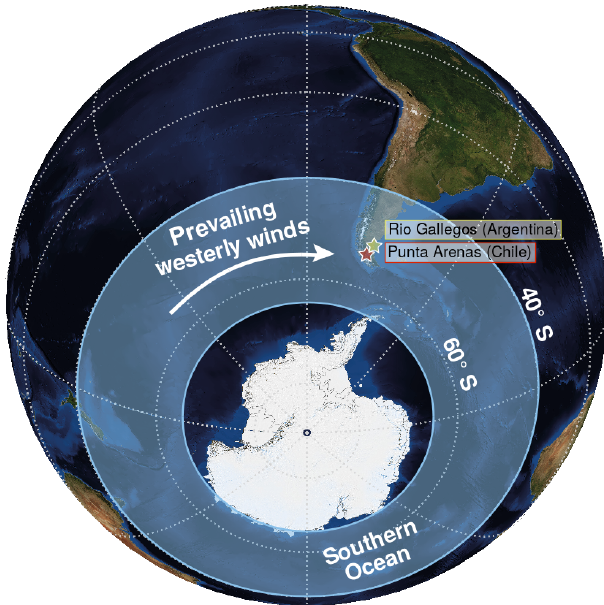
Figure 1. Map of Antarctica and South America. Punta Arenas and Rio Gallegos are marked by a red and a yellow star,